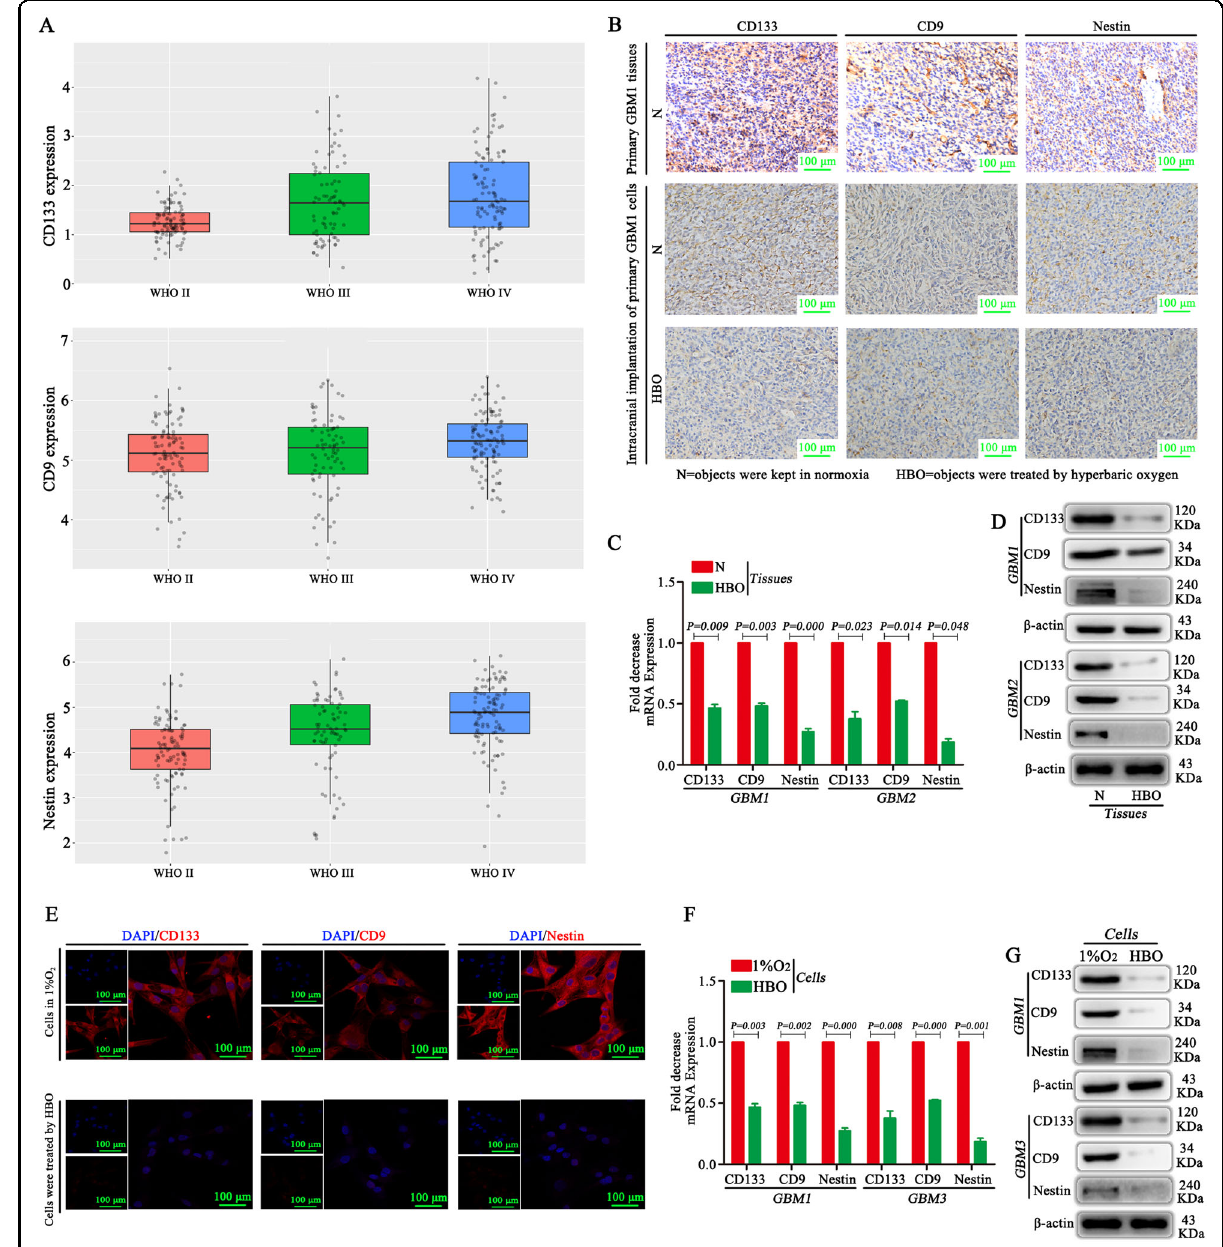
Fig. 5 Stemness markers are highly expressed in GBM, and HBO decreases their expression. A An analysis of the CGGA database revealed high expression of CD133, CD9 and Nestin in GBM. B IHC showed that CD133, CD9 and Nestin were highly expressed in primary GBM tissues and tumour tissues from mice that underwent intracranial transplantation; however, after HBO treatment, CD133, CD9 and Nestin expression decreased signi fi cantly. C , D RT-qPCR and western blot showed that CD133, CD9 and Nestin were highly expressed in the absence of HBO in the tumour tissues from mice that underwent intracranial transplantation, but after HBO treatment, all the proteins above were signi fi cantly decreased. E – G The in vitro study showed that after HBO exposure, the stemness markers CD133, CD9 and Nestin decreased compared with the control without HBO treatment based on immuno fl uorescence, RT-qPCR and western blot results. The P value was determined by an independent samples t